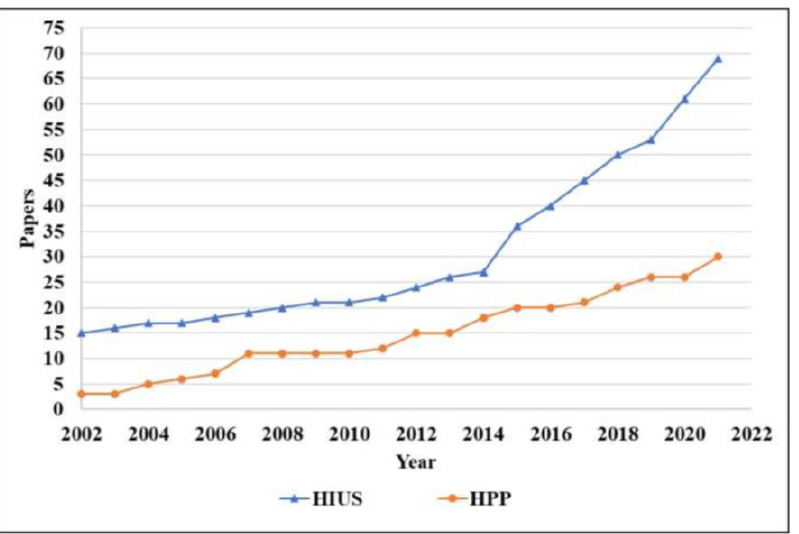
Figure 2. Temporal evolution (last 20 years) of articles on non-thermal technologies ’ application in meat tenderization before screening and inclusion steps. HIUS: high-intensity ultrasound, HPP: high-pressure processing.